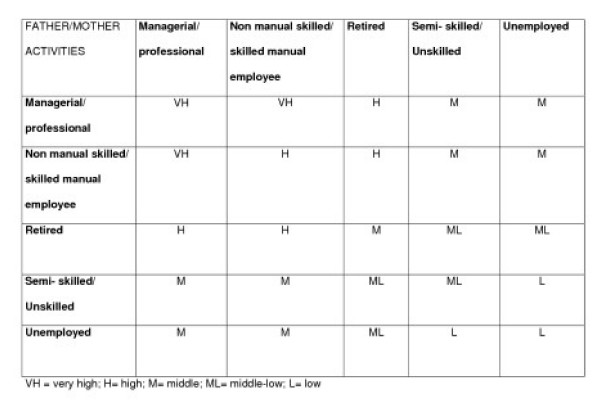
Family income index derived from the activities of the parents.